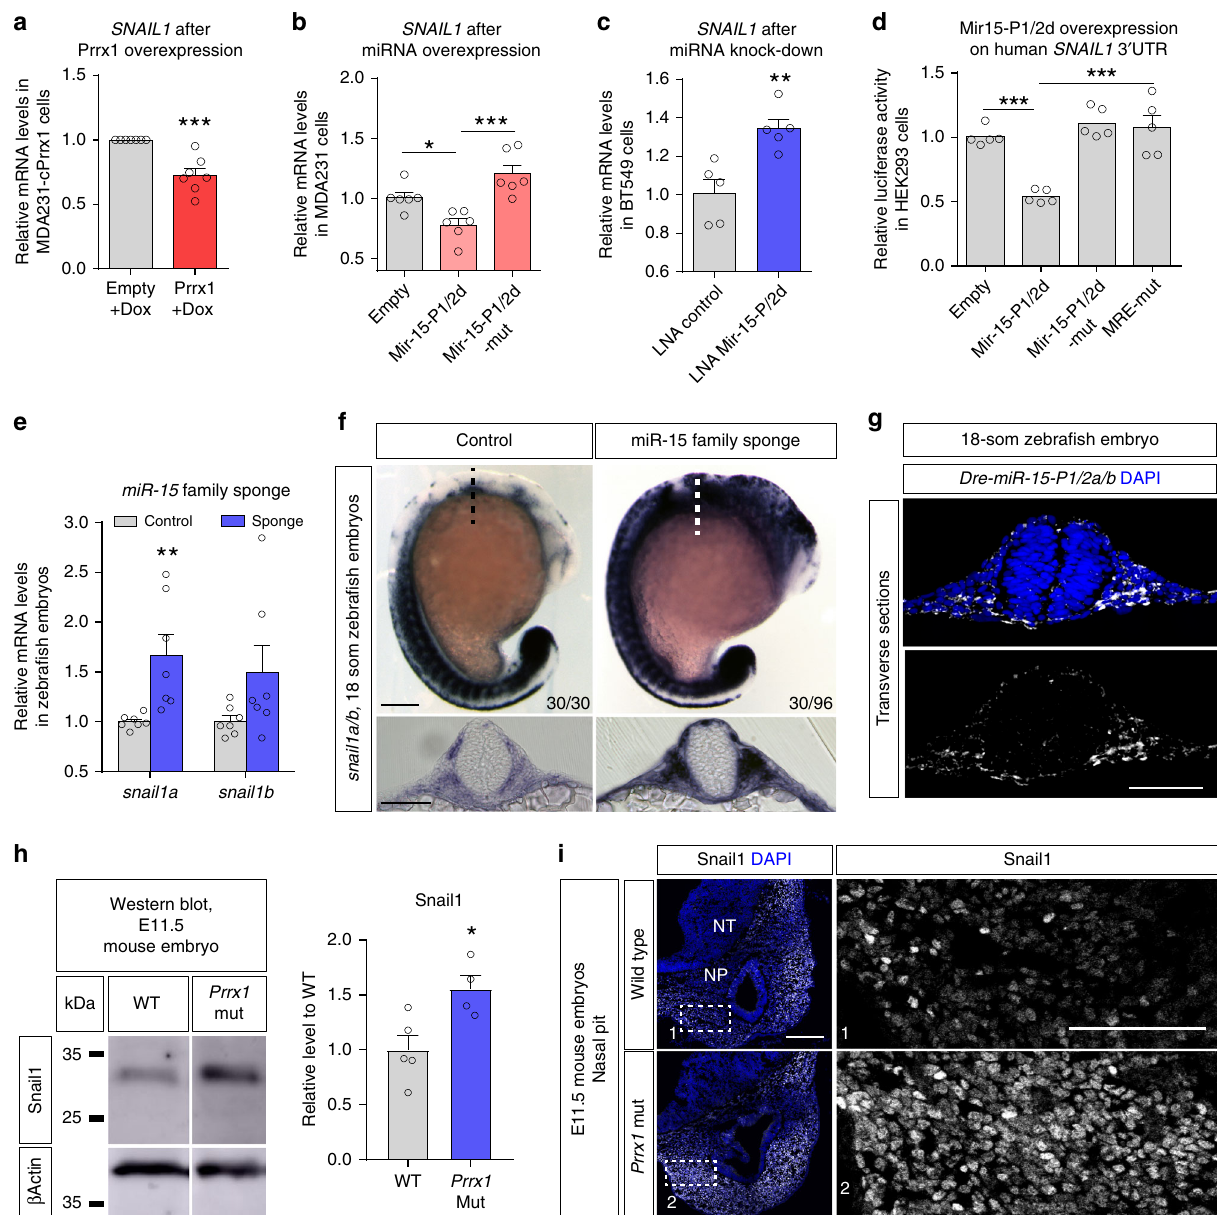
Fig. 4 Prrx1 attenuates Snail1 expression through the activation of miR-15 family members. a qPCR assay showing the downregulation of SNAIL1 upon conditional overexpression of Prrx1 in MDA231, induced by doxycycline after 48 h ( n = 7). b qPCR assay showing downregulation of SNAIL1 upon transient overexpression of Mir-15-P1/2d in MDA231 cells, using seed mutated miRNAs as control ( Mir-15-P1/2d-mut ) ( n = 6). c qPCR assay showing upregulation of SNAIL1 upon transient KD of in Mir-15-P1/2d in BT549 cells using miRNA LNA inhibitors ( n = 5). d Repression of human SNAIL1 3 ′ UTR after Mir-15-P1/2d overexpression, using seed mutated miRNAs ( Mir-15-P1/2d-mut ) or MRE mutant SNAIL1 3-UTR ( MRE-mut ) as control ( n = 5). e qPCR analysis shows upregulation of snail1a/b expression in the sponge-injected ( miR-15 family knocked-down) zebra fi sh embryos compared to controls ( n = 6). f 20-somite control or miR-15 family sponge-injected zebra fi sh embryos showing combined snail1a/b expression by in situ hybridization. Transverse sections taken at the levels indicated by the dashed lines. Scale bar: 250 μ m. g Fluorescent miRNA in situ hybridization to detect mature miRNAs in transverse sections of 20-somite zebra fi sh embryo, showing the expression of Dre-miR-15-P1/2a/b in neural crest derived cell populations. Scale bar: 250 μ m. h Western blot for Snail1 and β -actin from E11.5 control and Prrx1 mutant embryos, including quanti fi cation of intensity of Snail1 signal ( n = 5 WT, 4 KO). i Snail1 IF in the nasal pit regions of E11.5 WT and mutant embryos. Scale bar: 250 μ m for NP sections and 100 μ m for insets (boxes 1 and 2). MRE miRNA responsive element, LNA locked nucleic acid, WT wild type, Mut mutant, NT neural tube, NP nasal pit. Quanti fi cations are performed for one section of WT or mutant embryos, and the increase and expansion is observed in n = 2/2 mutant embryos compared to n = 3/3 different E11.5 WT. Bars represent mean plus SEM, indicated ( n ) represent number of independent experiments as biological replicates and asterisks indicate signi fi cant p value in t test for a, c, e, h and one-way ANOVA with Bonferroni ’ s multiple comparison test for ( b ), ( d ) (* p < 0.05, ** p < 0.01 and *** p < 0.001). Source data are provided as a Source Data fi